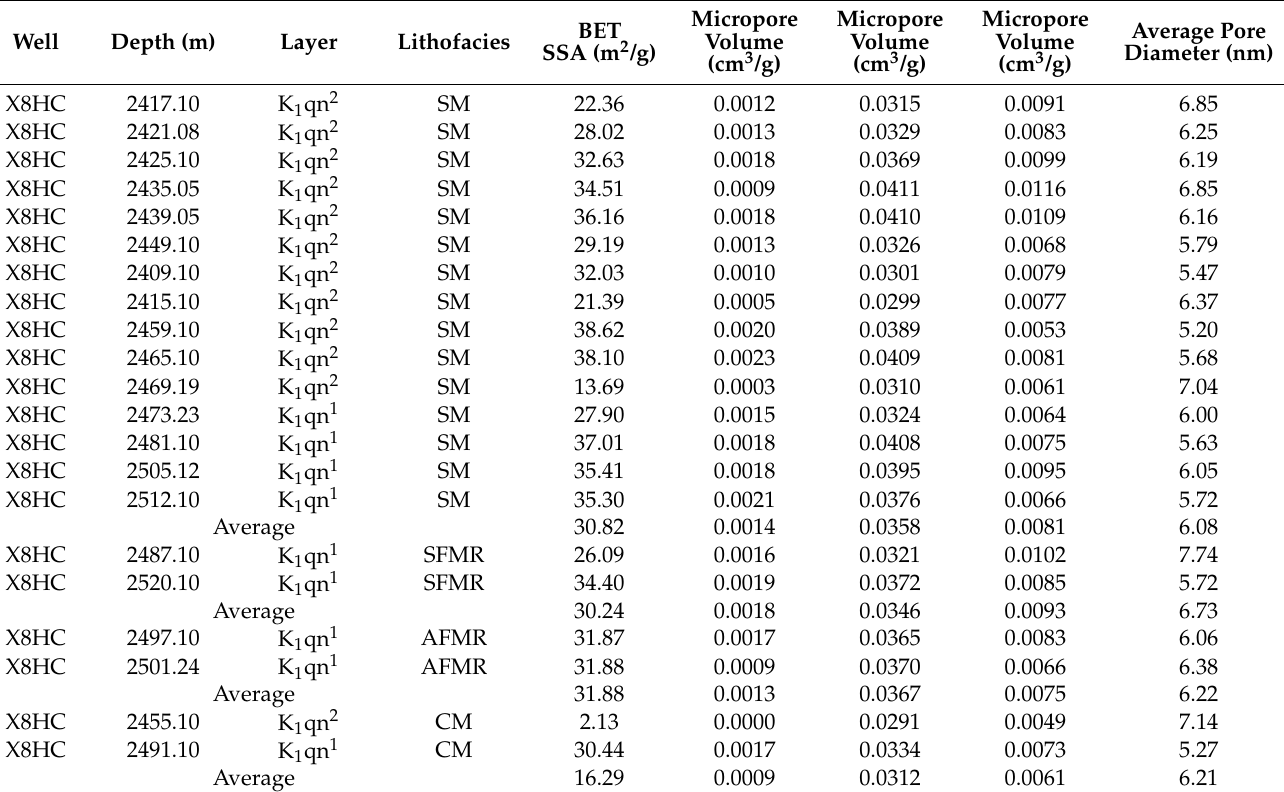
Figure 14. Typical N 2 adsorption and desorption isotherms of different lithofacies of FGSRs. ( A ) SM; ( B ) SFMR; ( C ) AFMR; ( D ) CM. Table 2. SSA and average adsorption pore diameter of different lithofacies of FGSRs in the Qing- shankou